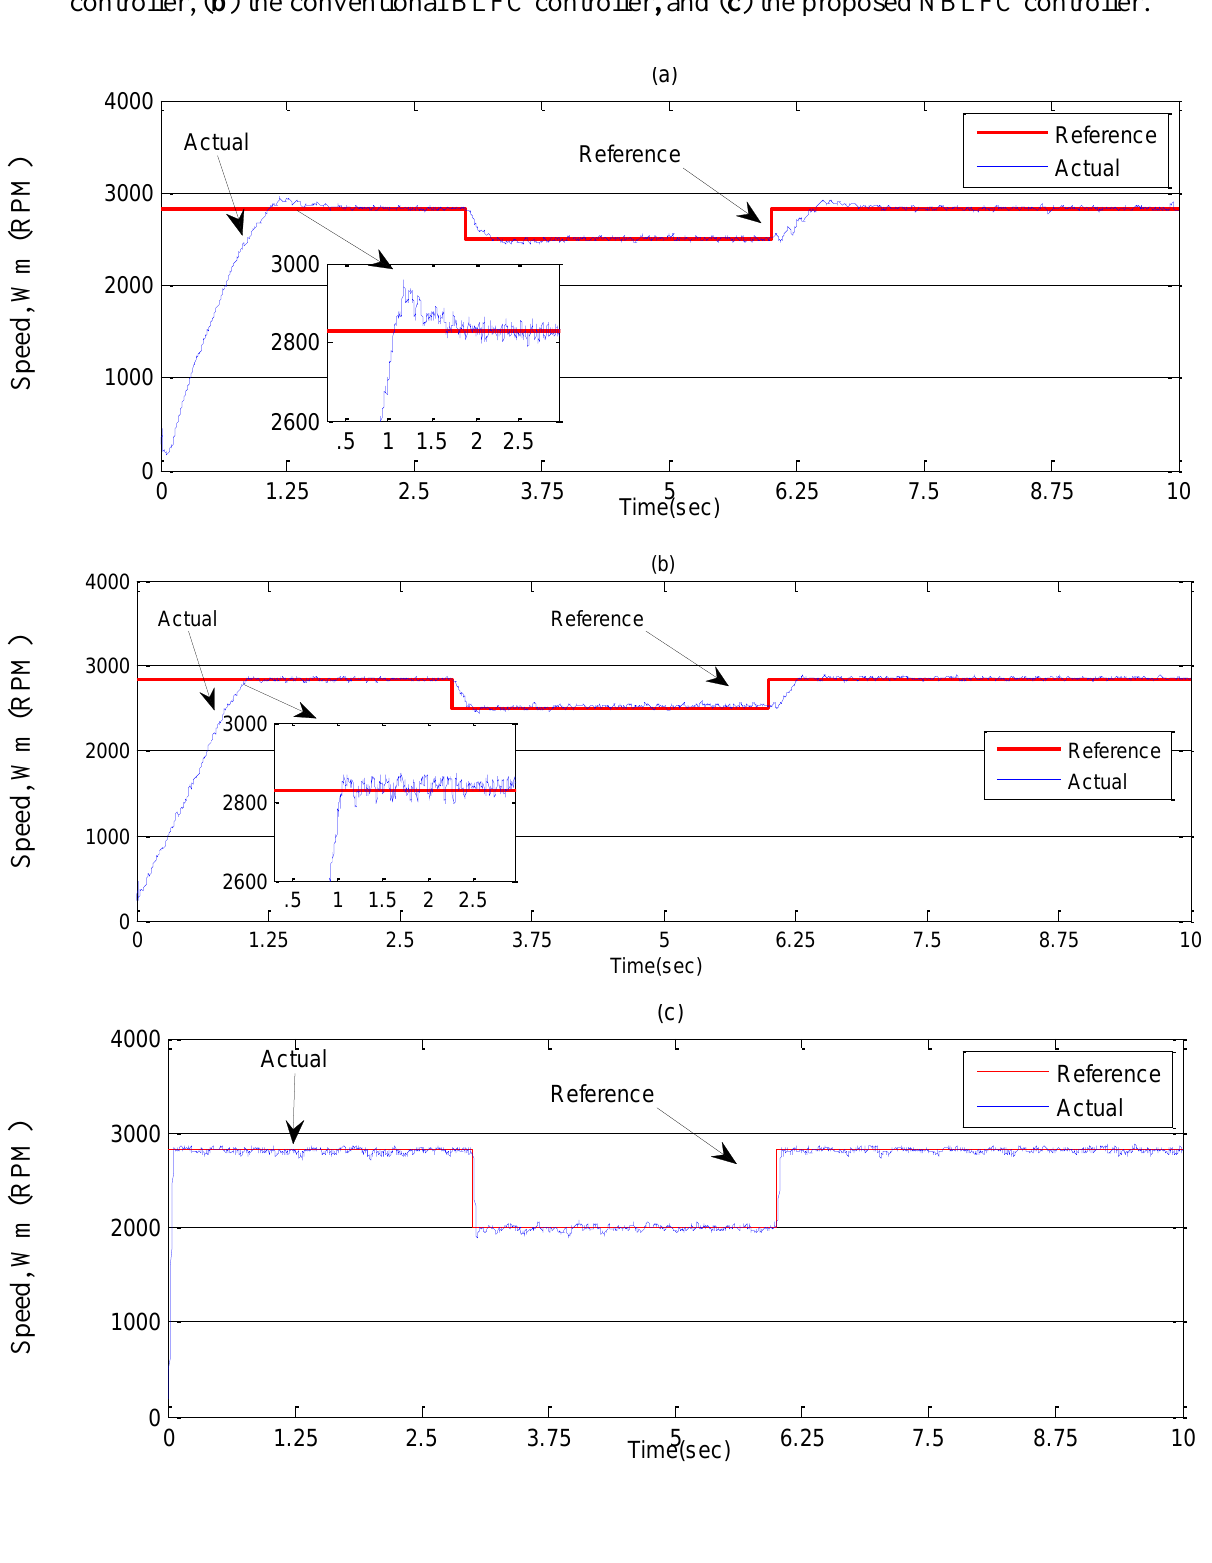
Figure 17. Experimental speed responses-based IM drive in Case-1 ; ( a ) the tuned PI controller, ( b ) the conventional BLFC controller , and ( c ) the proposed NBLFC